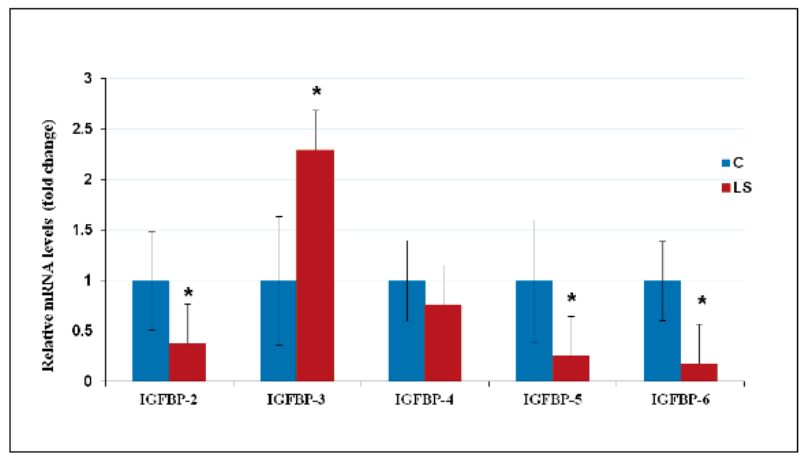
Figure 5. QRT-PCR analysis of IGF-binding protein (IGFBP) mRNA levels in LS cells. Lymphoblastoid cell lines derived from four LS patients (red bars) and four controls (blue bars) of the same age range, gender, and ethnic origin were harvested, after which total RNA was prepared and IGFBPs’ mRNA levels were measured by QRT-PCR. Primers employed are described in [84]. For each IGFBP mRNA, a value of 1 was given to the level exhibited by control cells. Bars denote mean ± SD ( n = 4). *, p < 0.05 versus respective control. Data shown here were originally reported in [84].